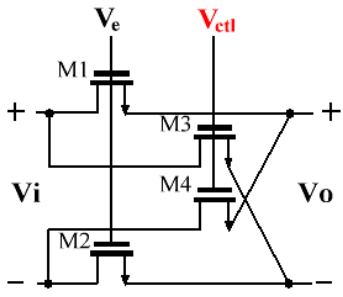
Figure 10. Transistor-level schematic of the differential tunable metal-oxide semiconductor (MOS) resistance.